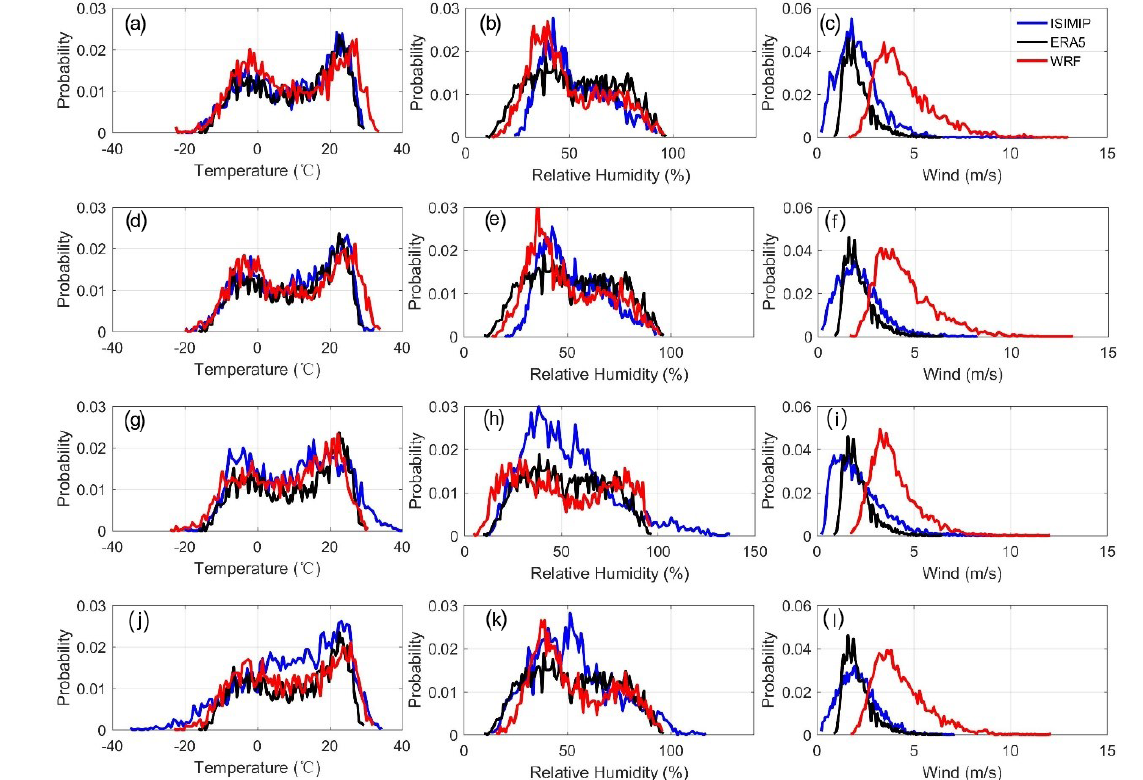
Figure 4. The probability density function (pdf) for daily mean temperature, relative humidity and wind speed for MIROC-ESM (a–c) , MIROC-ESM-CHEM (d–f) , HadGEM2-ES (g–i) and BNU-ESM (j–l) under WRF (red lines) and ISIMIP statistical bias-correction method (blue lines) in the Beijing province (Fig. 1) during 1980–1989. The black line is ERA5 reanalysis data. Values of humidity exceeding 100% can occur with ISIMIP